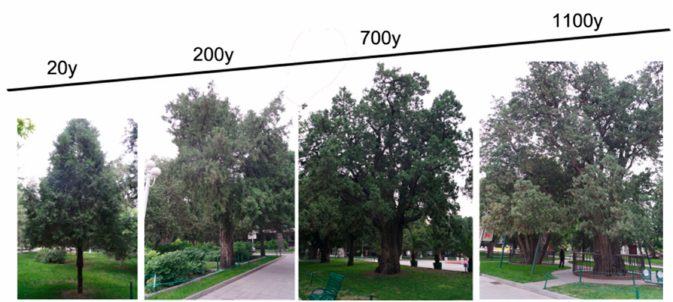
Figure 1. The trees sampled were 20-, 200-, 700-, and 1100-year-old individuals of Platycladus orientalis in Zhongshan Park,